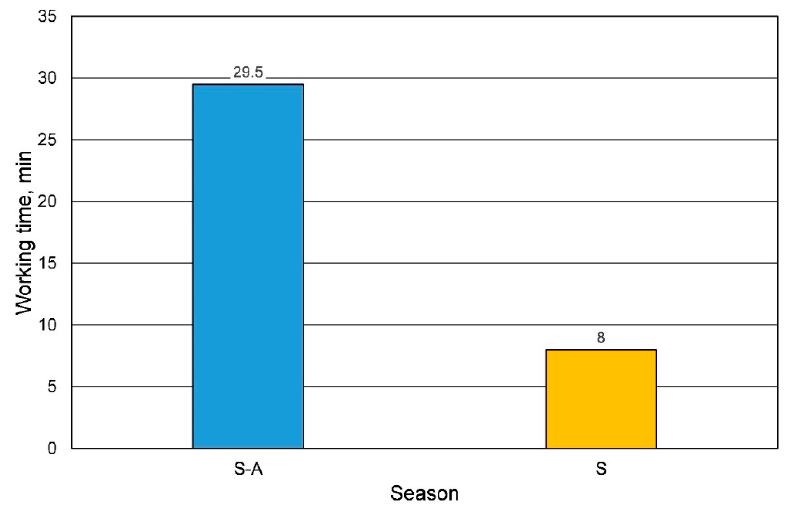
Figure 2. Lifetime of the molding sand, depending on the season.